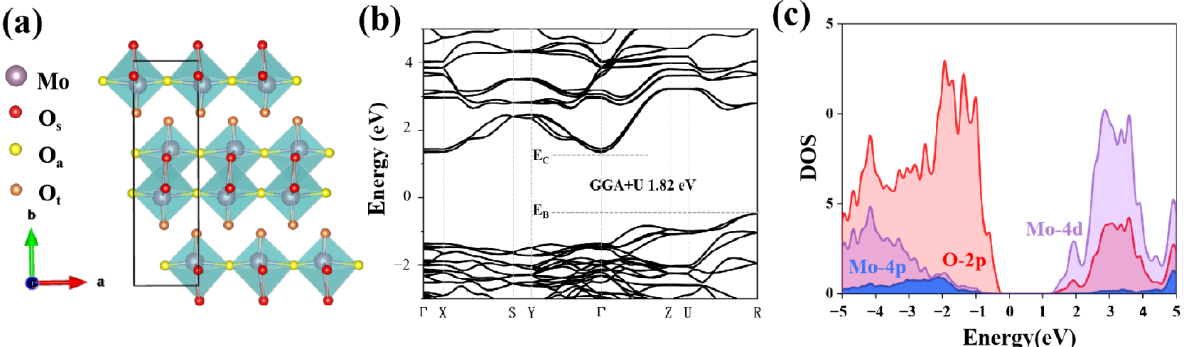
Figure 1. ( a ) The crystal structure of two-dimensional α -MoO 3 . ( b ) The calculated band structures of α -MoO 3 unit cell. ( c ) The partial density of states (PDOS) of intrinsic α -MoO 3 . As shown in Figure 2a, to find the most stable doping position, five sites were selected in interlayer or intralayer according to the symmetry of α -MoO 3 . For the interlayer positions, H atoms bonded with O t , O s and O a when they doped into A 1 , A 2 and A 3 sites, respectively. For the intralayer positions, H atoms bonded with O a and O s when they doped into B 2 and B 3 sites, respectively. As we can see in Figure 2b, in comparison with the total energies of the different systems it was found that when H is doped at the concentration of 4%, it is easier to form a coordination bond with O a , and the intralayer doped system is more stable than the interlayer doped system because the corresponding system